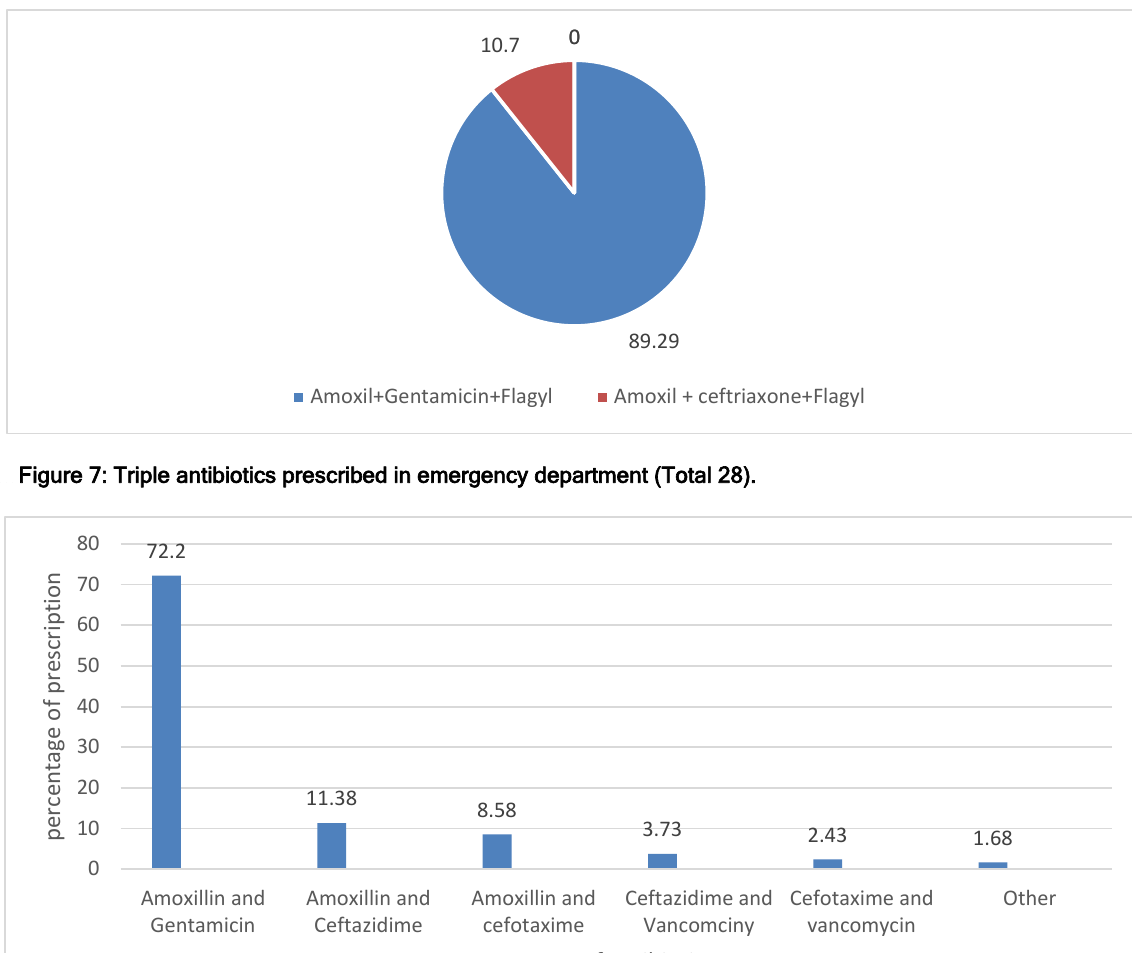
Figure 6: Double antibiotics prescribed in emergency department (Total 392).